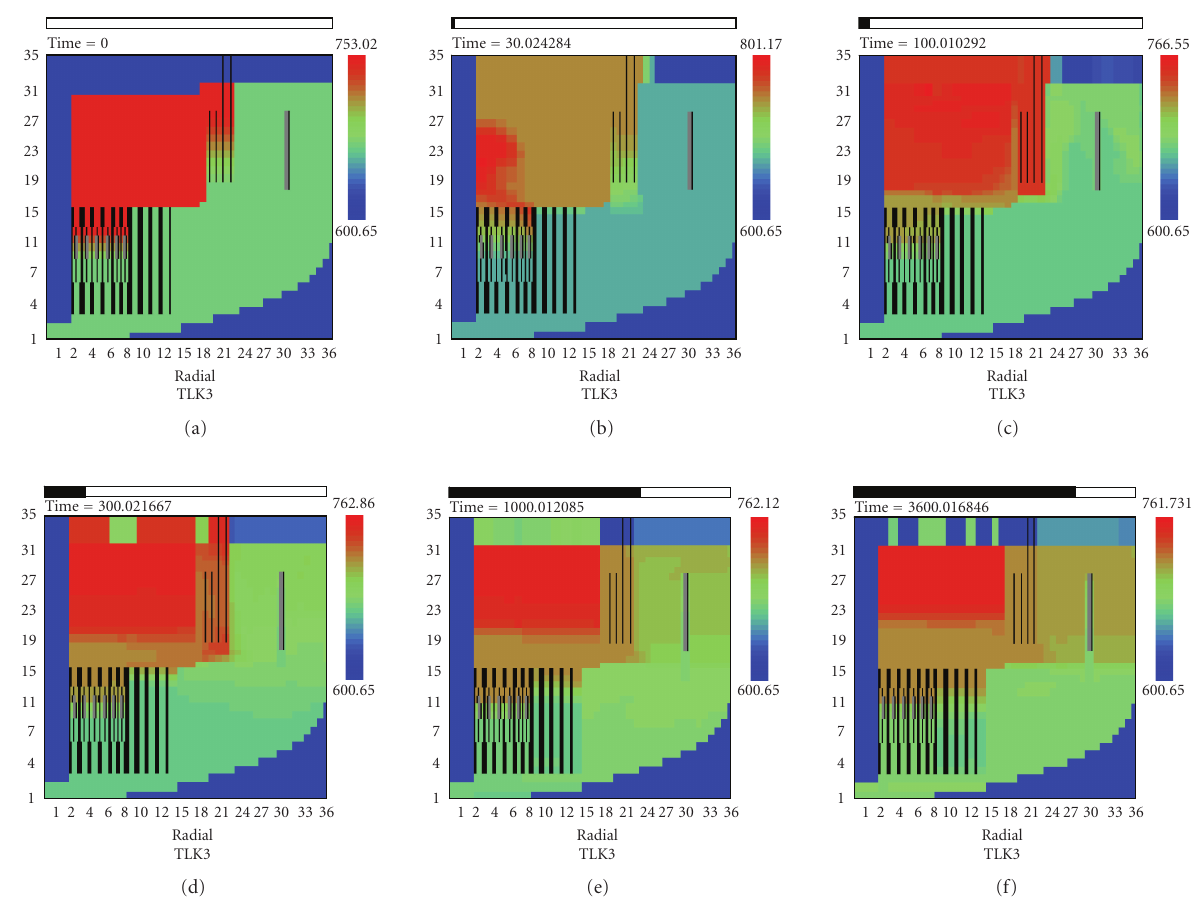
Figure 4: Time evolution of lead temperature (K) distribution in the primary